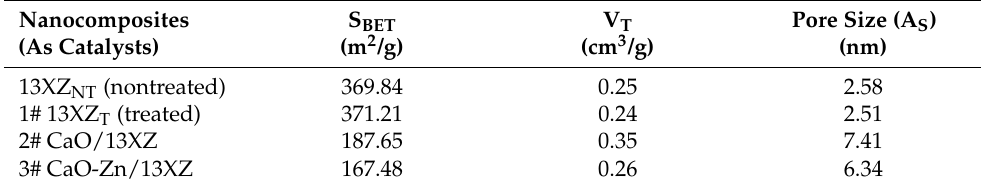
Table 2. Surface area and total pore volume of the nanocomposites prepared and used as catalysts.